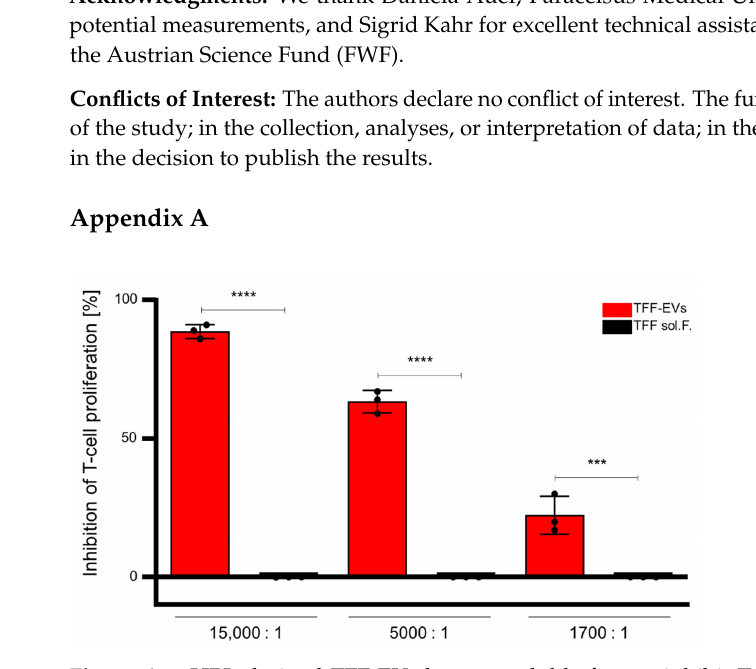
Figure A3. Wound healing scratch assay. Human skin fibroblasts from two healthy donors were seeded in scratch assay chambers before treatment with different HPL-derived EV and soluble frac-